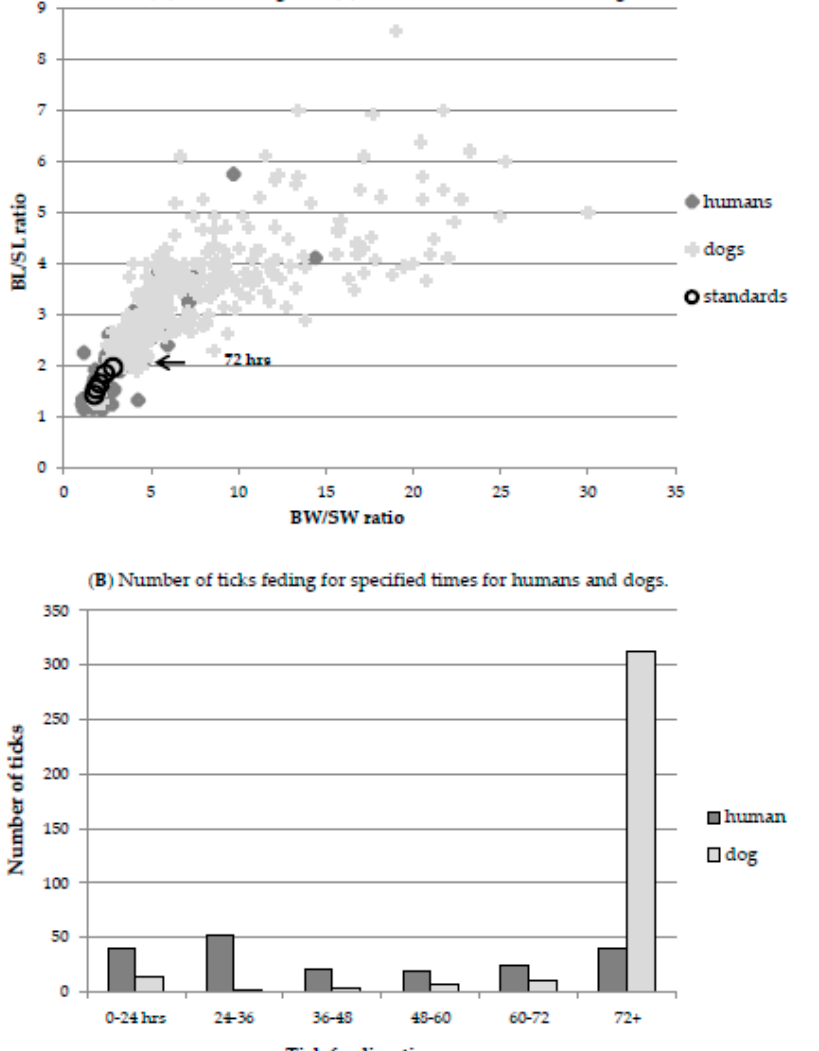
Figure 3. Tick feeding time (F) for ticks from humans and dogs. Tick engorgement indicates